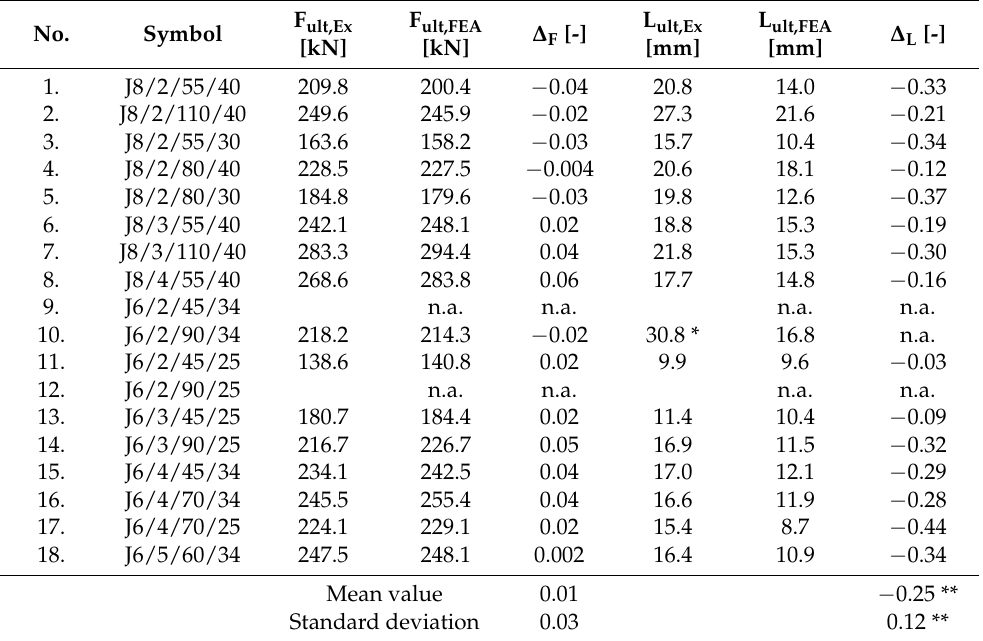
Figure 9. Specimen J6/3/45/25 in the failure phase: ( a ) experiment, ( b ) FEA model, ( c ) F– Δ curves.